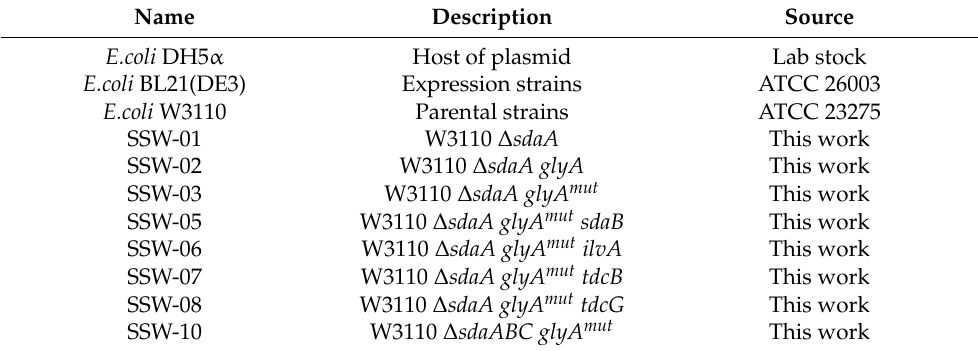
Table 1. The strains used in the experiment.